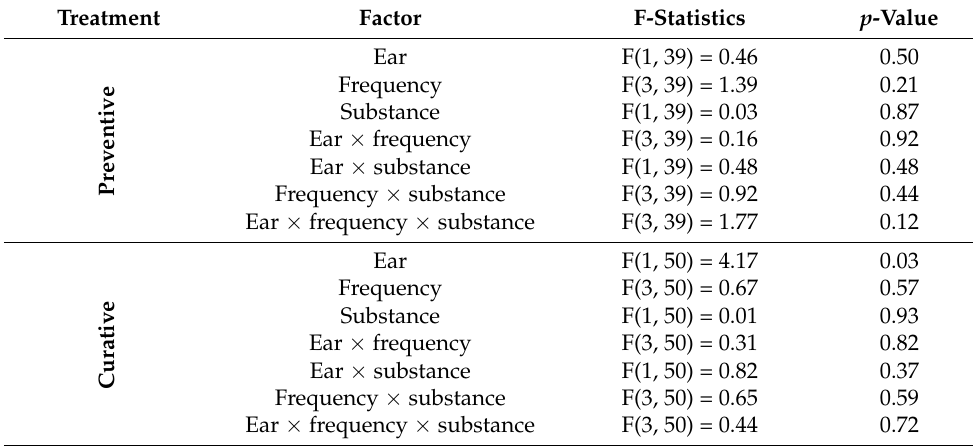
Table 2. Results of repeated-measurement ANOVAs of animals’ hearing loss in preventive and curative effect